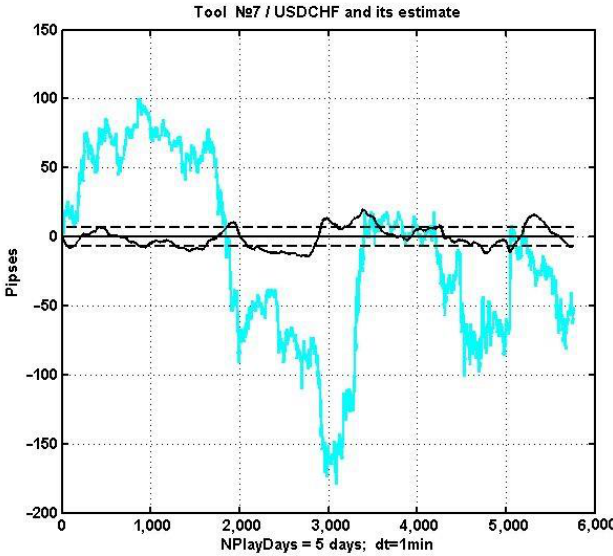
Figure 7. Changes in the quotation of a currency instrument and a decision statistic (an oscillator) on a five-day interval.